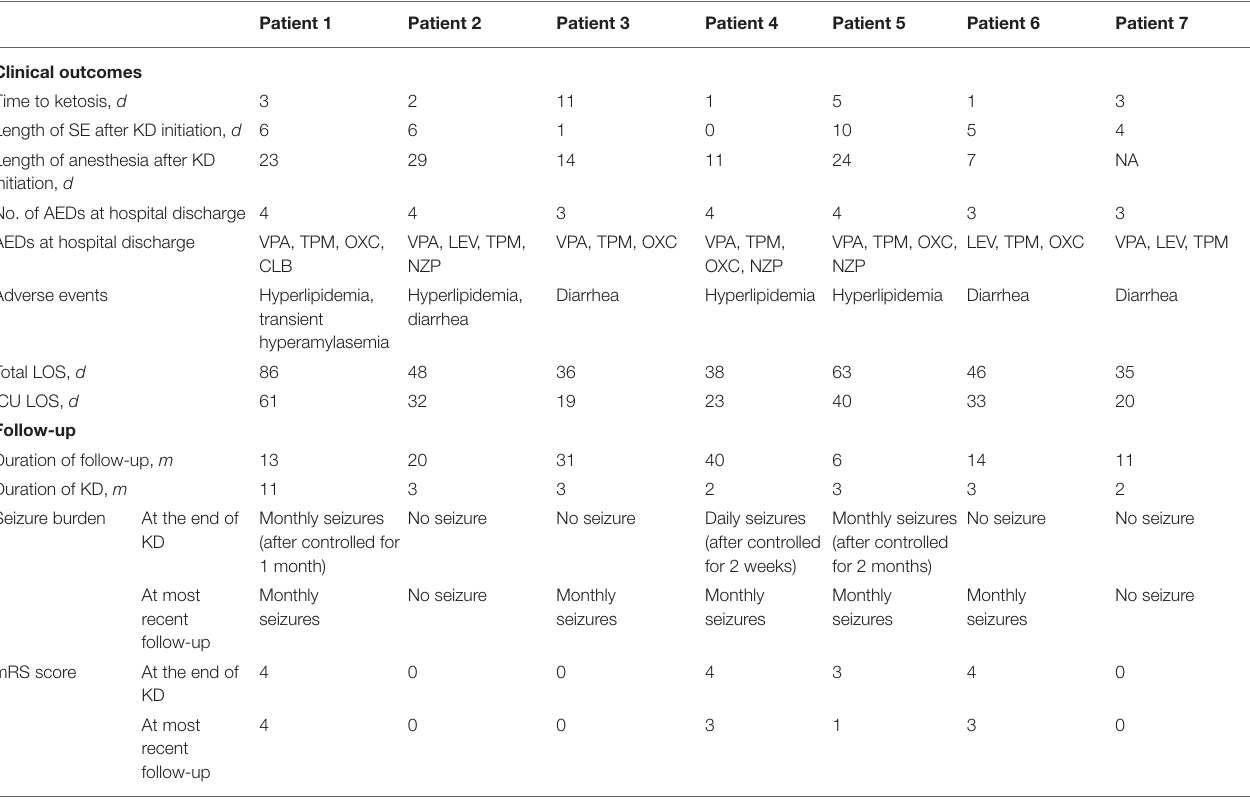
TABLE 3 | Patient in-hospital and long-term